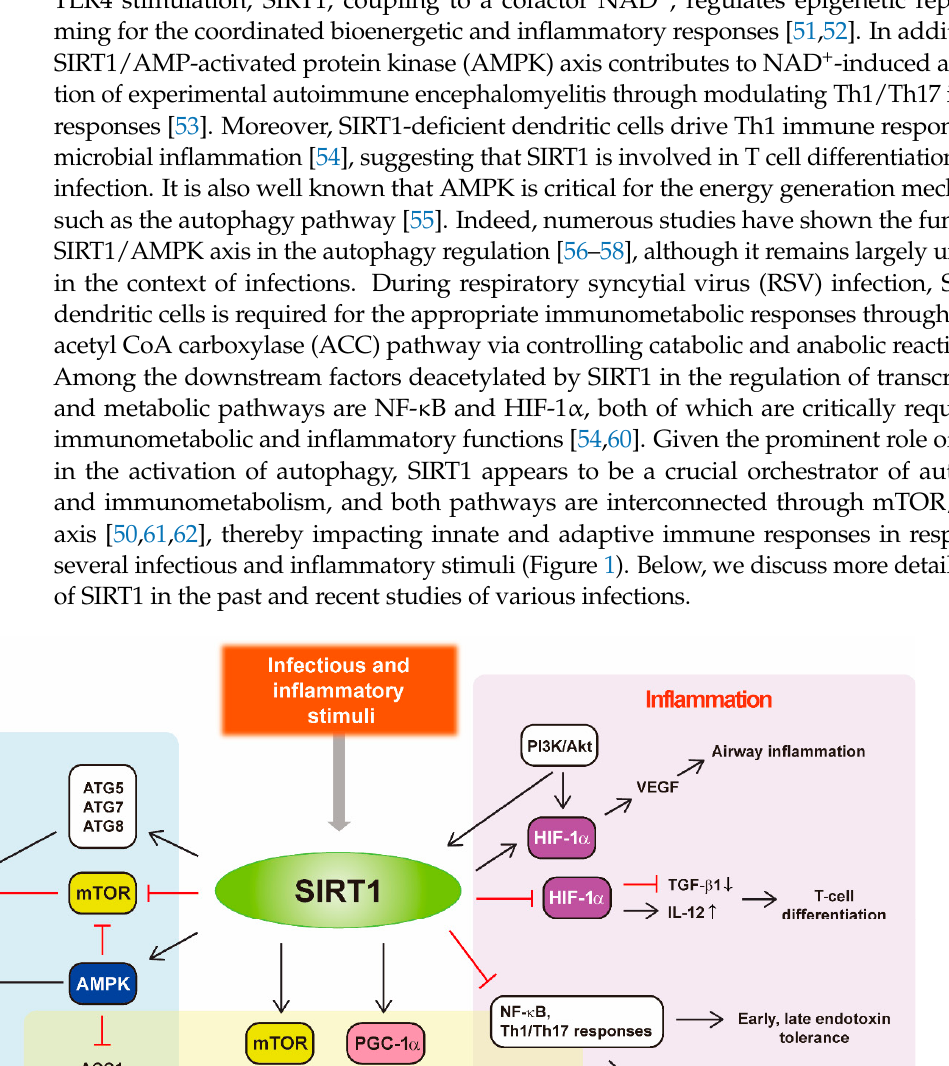
SIRT1 controls mitochondrial biogenesis and fatty acid β -oxidation by activating PGC-1 α